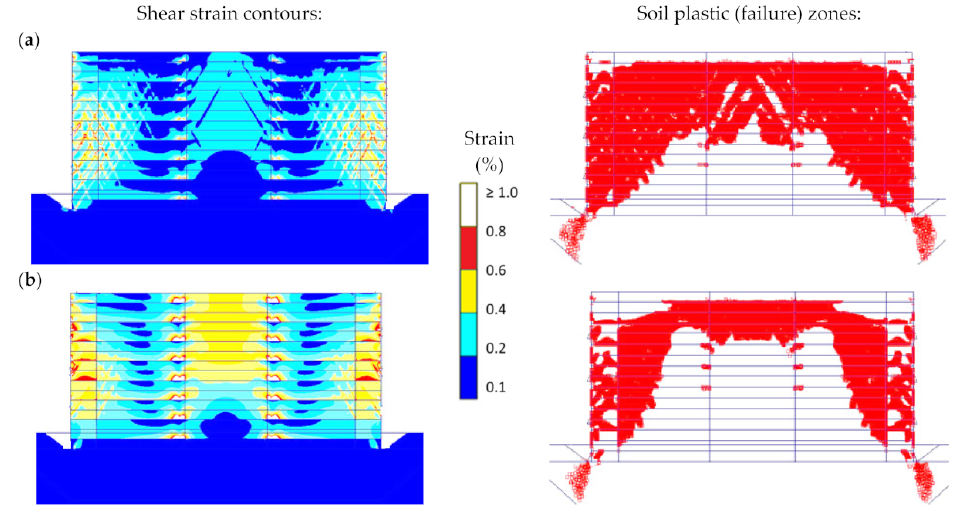
Figure 19. Shear strain contours and plastic (failure) zones in the soil at the end of construction for the D i = 0.6 H case. Strip pre-tension loads: ( a ) T i = 0.5 kN/strip and ( b ) 1 kN/strip. Note: results range from 0–1% for shear strain contours, and white zones on top of the models represent the location of tension cut-off points for soil plastic zones). (Modified from